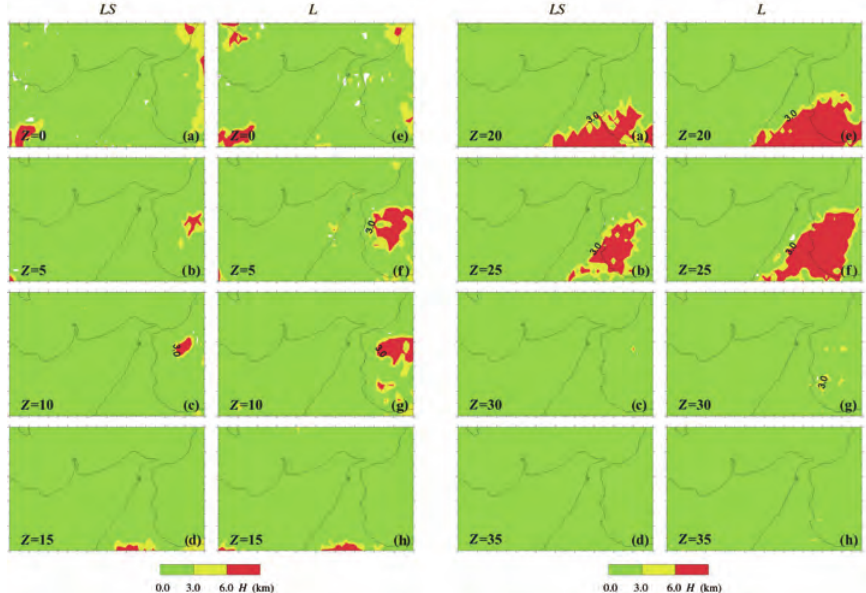
Fig. 10. Comparison of H -parameter horizontal distributions at different depths like in fig. 7. The standard de- viation of the random noise perturbation of synthetic arrival times is 0.05